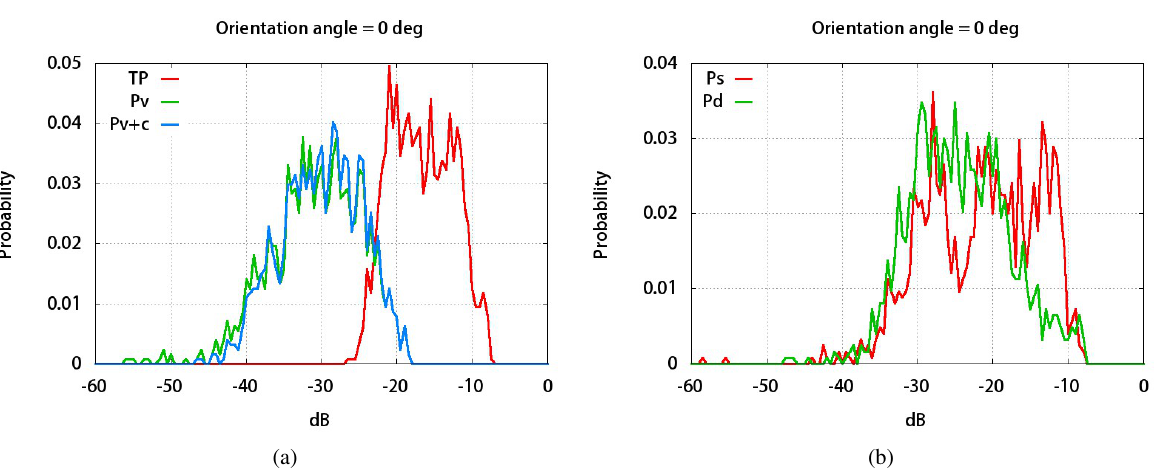
Figure 5. Histograms of scatterings when the orientation angle of the concrete blocks was set to 0 ◦ . (a) TP , P v , and P v + c , and